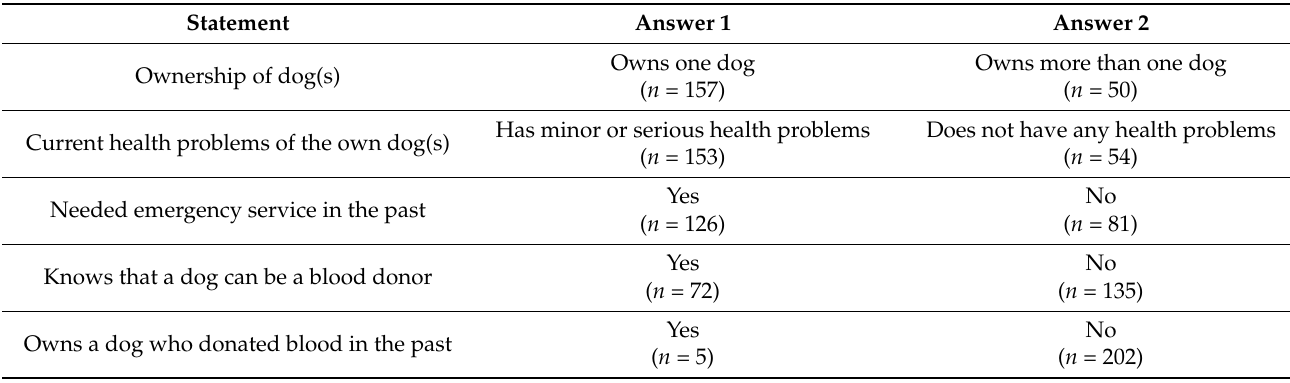
Table 1. Survey respondents’ information about owned dog(s) and level of knowledge about canine blood